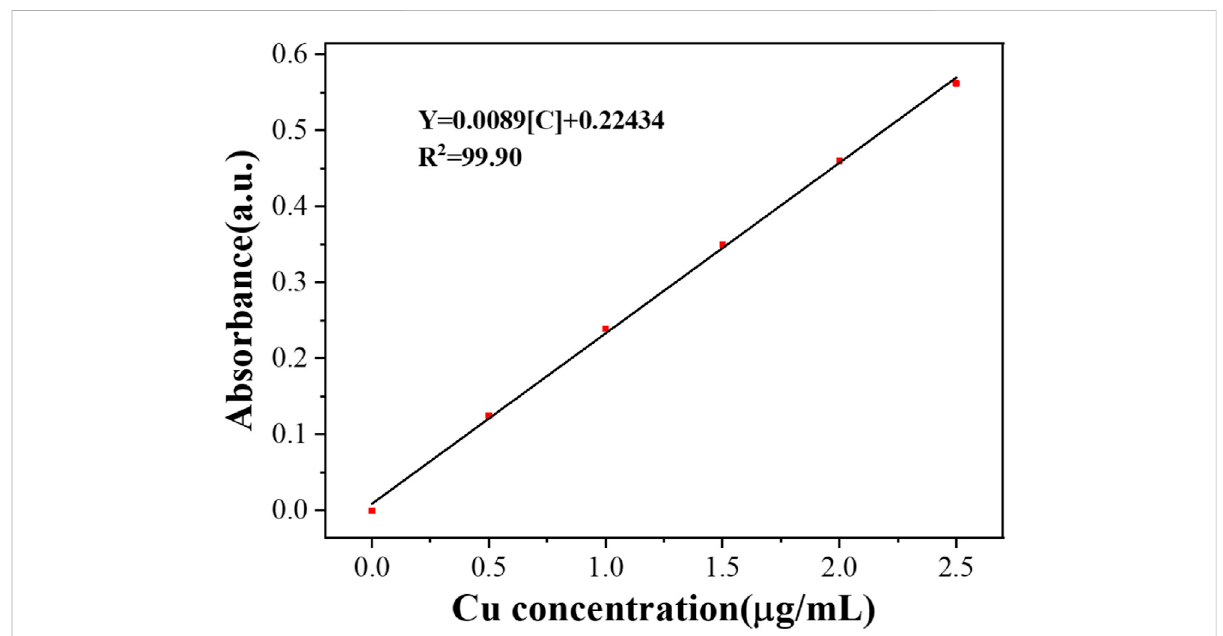
The linear calibration plot for Cu concentration by using Atomic Absorption Spectroscopy.